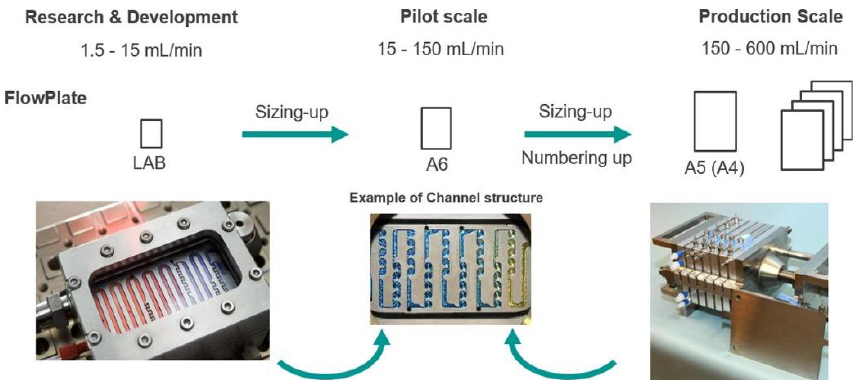
Figure 7. Plate scale-up concept for the nitration process; Reprinted with permission from ref [94]. Copyright 2020 American Chemical Society.